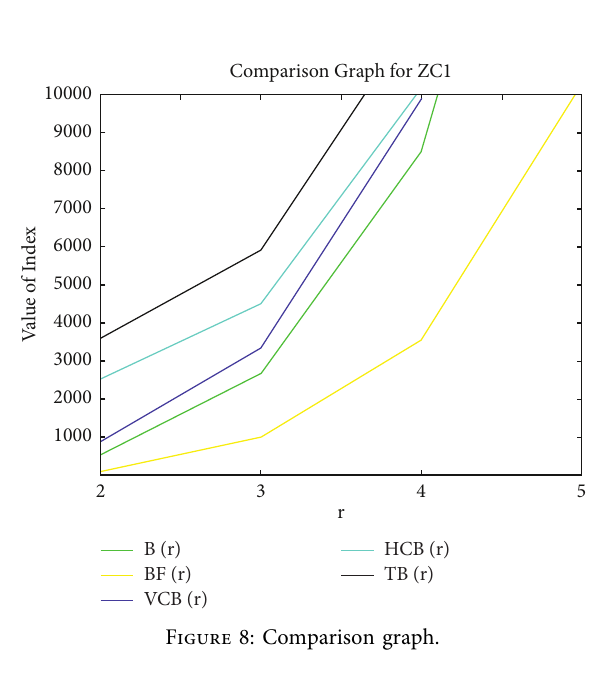
Figure 8: Comparison